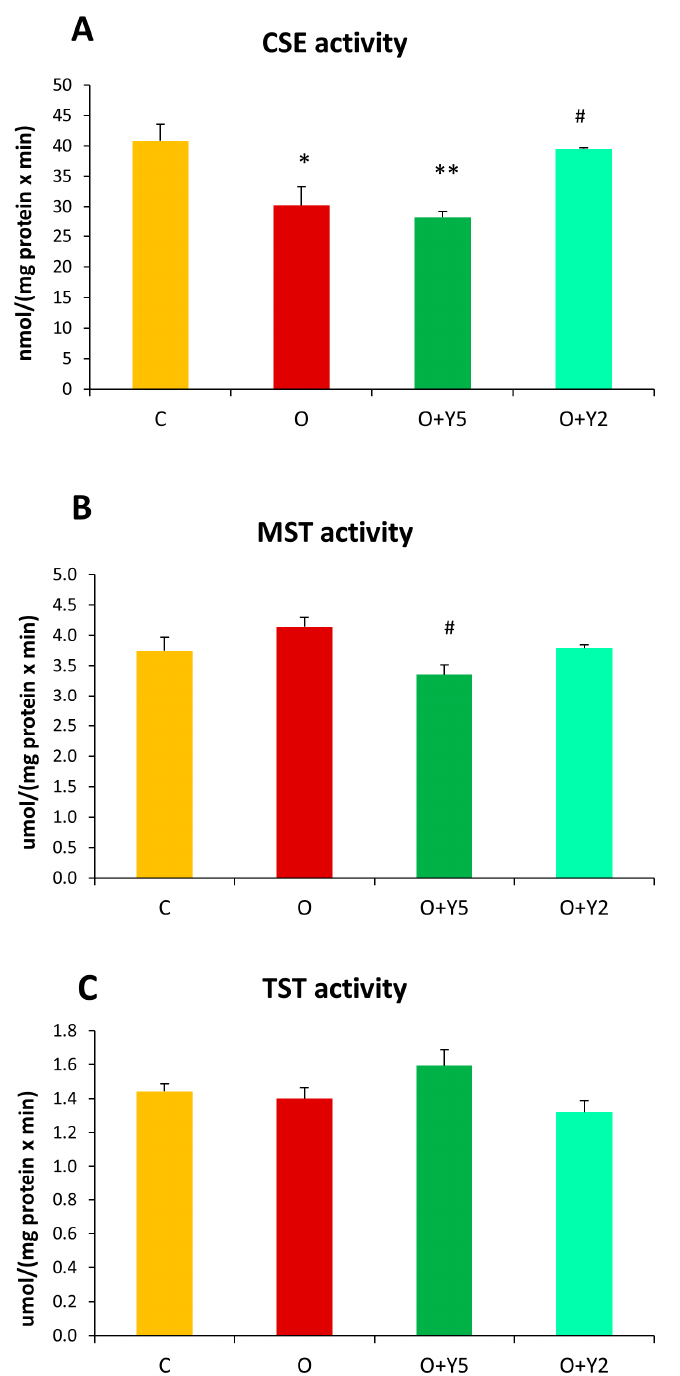
Figure 4. The activity of cystathionine γ -lyase (CSE) ( A ), 3-mercaptopyruvate sulfurtransferase (MST) ( B ), and rhodanese (TST) ( C ) in the livers of rats. C—control rats fed a standard diet; O—rats fed with HFD; O + Y5—rats fed with HFD and treated intraperitoneally (i.p.) with yohimbine at a dose of 5 mg/kg/day for 30 days; O + Y2—rats fed with HFD and treated intraperitoneally (i.p.) with yohimbine at a dose of 2 mg/kg/day. Data are presented as the mean ± SEM, n = 6 per group. Statistical analysis was performed using a one-way ANOVA; symbols indicate significance of differences according to the Tukey post hoc test, * p < 0.05, ** p < 0.01 vs. group C; # p < 0.05 vs. group O.